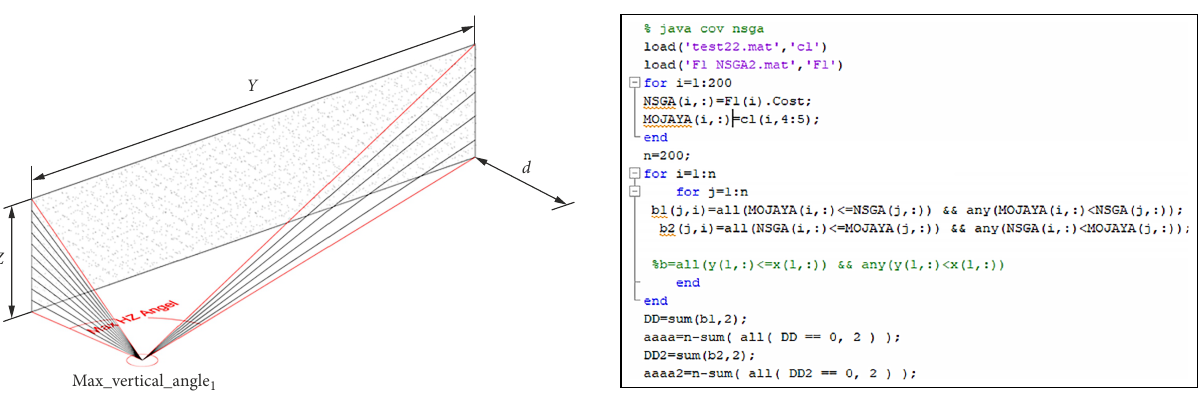
Figure 5. An example of vertical steps for two different horizontal angles for density calculations